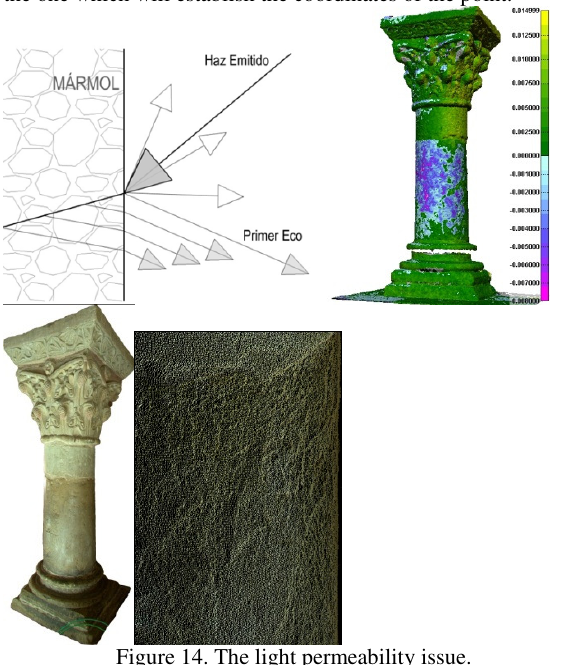
Figure 14. The light permeability issue.